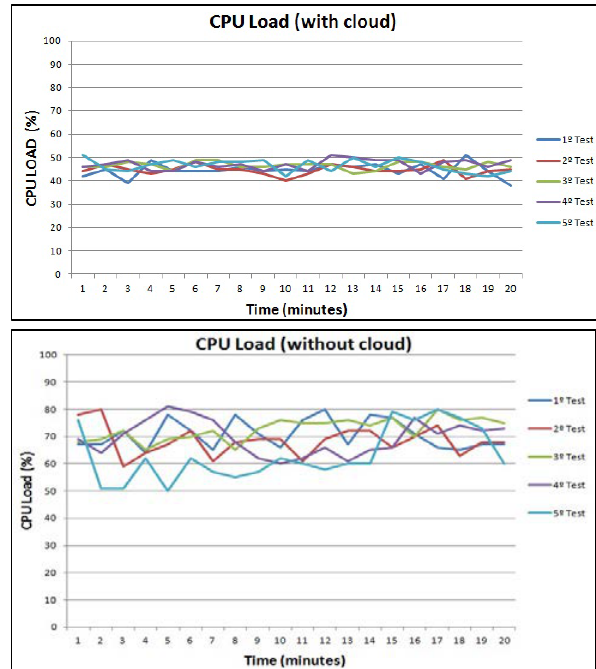
Figure 5. CPU Load with and without cloud.